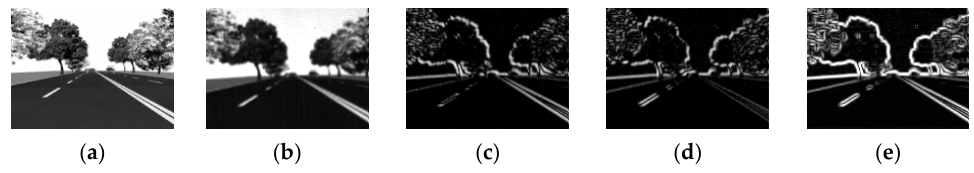
Figure 10. ( a ) Original image and ( b ) CIS image. Edge detection images of ( c ) G x , ( d ) G y , and ( e ) G x + G y .